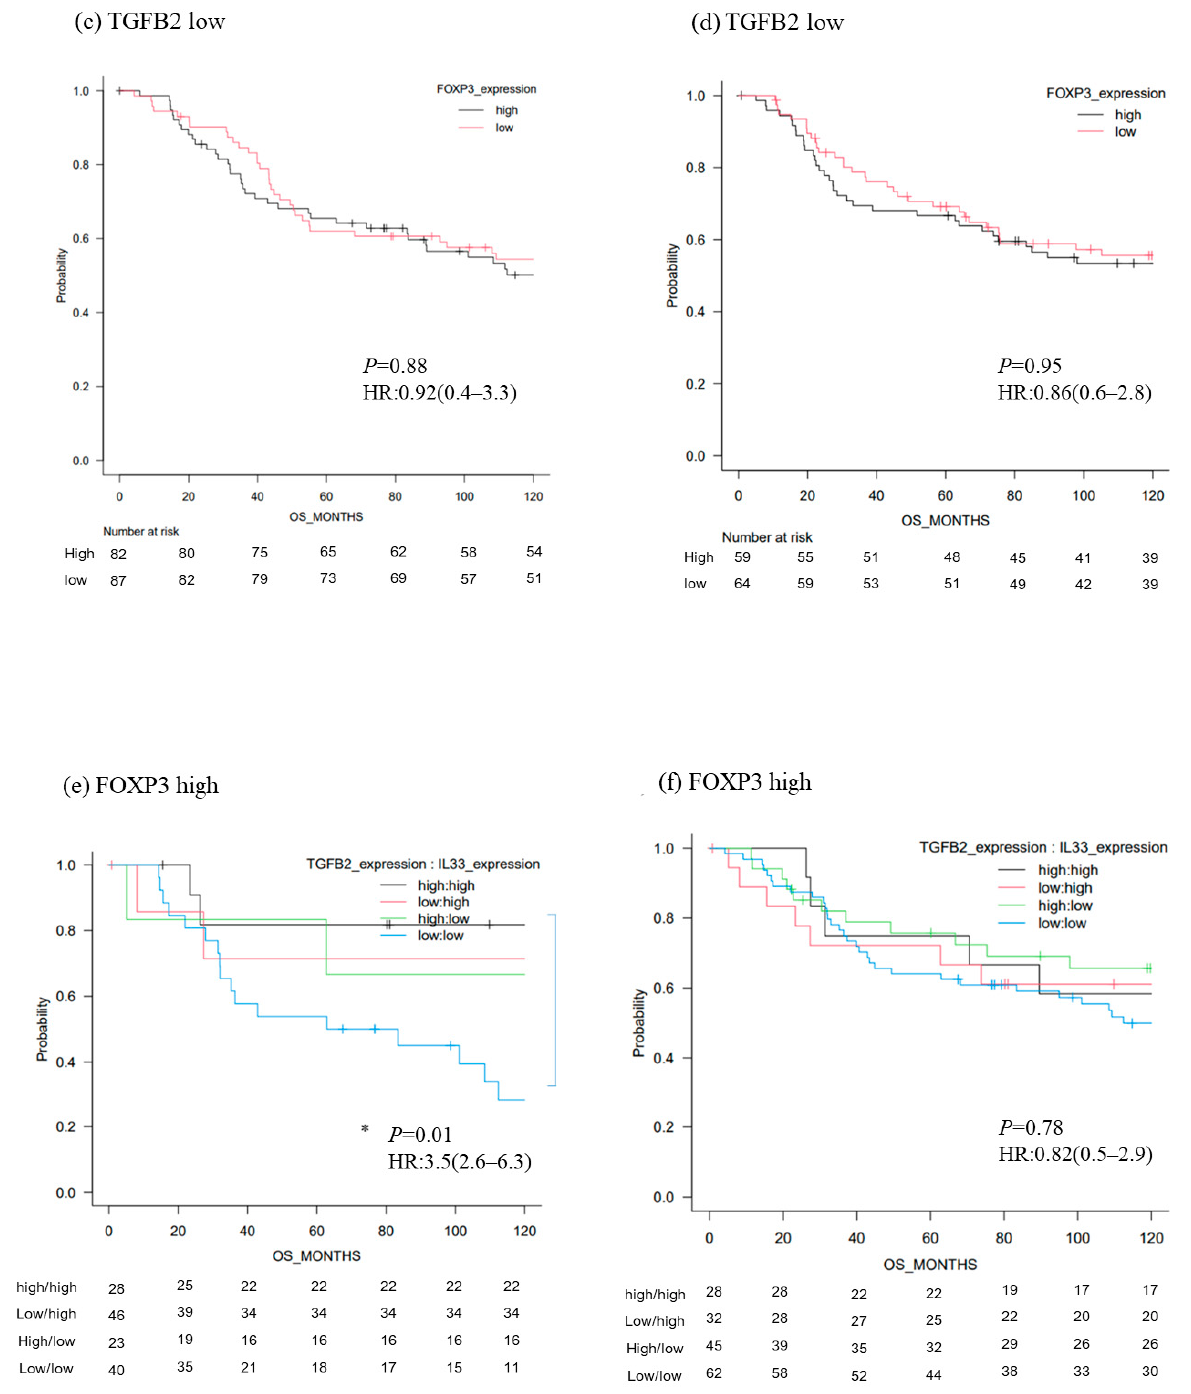
Figure 4. Overall survival of patients with TNBC in TGCA and METABRIC cohorts according to FOXP3 mRNA levels under different conditions of IL-33 and TGFB2 mRNA levels ( n = 302). ( a ) FOXP3 high vs. low in the IL-33-low group ( n = 200). ( b ) FOXP3 high vs. low in the IL-33-high group ( n = 102). ( c ) FOXP3 high vs. low in the TGFB2-low group ( n = 153). ( d ) FOXP3 high vs. low in the TGFB2-high group ( n = 153). ( e ) Four groups (IL-33 high/TGFB2 high, IL-33 high/TGFB2 low, IL-33 low/TGFB2 high, and IL-33 low/TGFB2 low groups) in the FOXP3-high group ( n = 135). ( f ) Four groups (IL-33 high/TGFB2 high, IL-33 high/TGFB2 low, IL-33 low/TGFB2 high, and IL-33 low/TGFB2 low groups) in the FOXP3-low group ( n = 167). *: p <